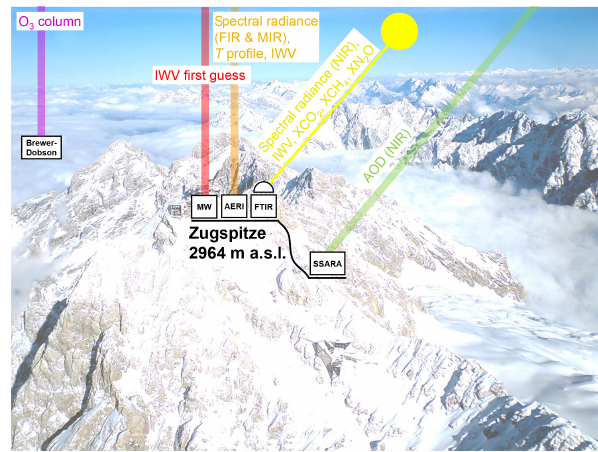
Figure 1. Instrumental setup of the Zugspitze radiative closure ex- periment covering the FIR, MIR, and NIR spectral range (FTIR: Bruker IFS 125 HR high-resolution solar Fourier transform infrared spectrometer; AERI: extended-range Atmospheric Emitted Radi- ance Interferometer; MW: LHATPRO (low-humidity and tempera- ture profiling) microwave radiometer; SSARA (Sun-Sky Automatic RAdiometer – Zugspitze): sun photometer; Brewer–Dobson: ozone